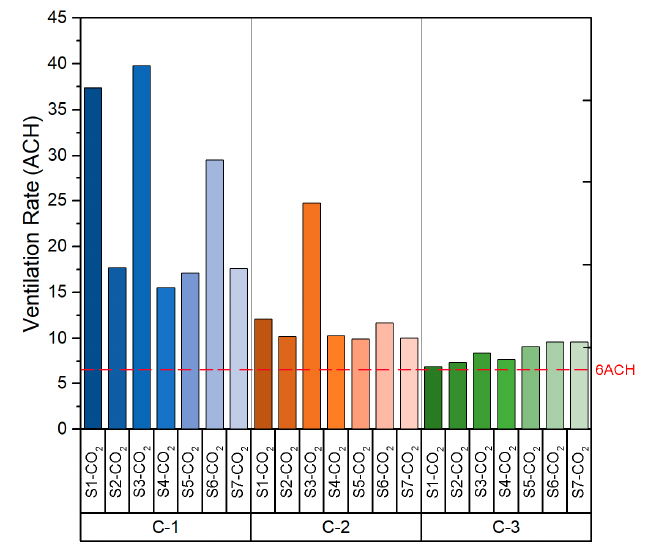
Figure 10. Ventilation rates (ACH) in Classroom B2-A1.